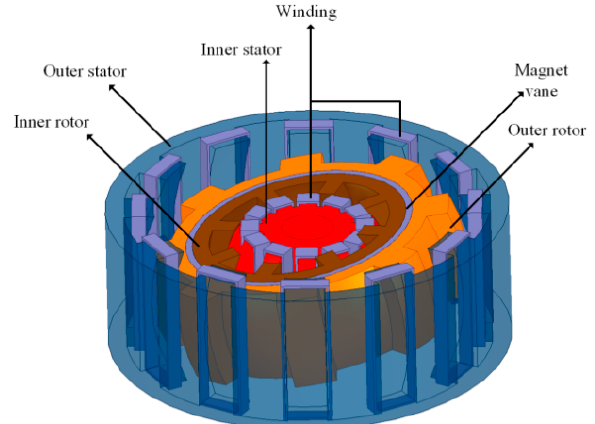
Figure 1. The structure of DSRM. Figure 2. DSRM in deflection motion.